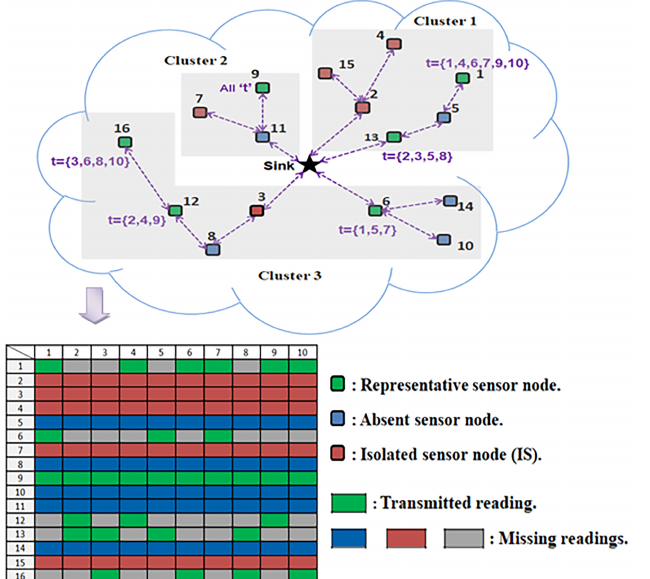
Figure 1. An illustrative miniature Wireless Sensor Network (WSN) with the resulting transmitted data matrix M